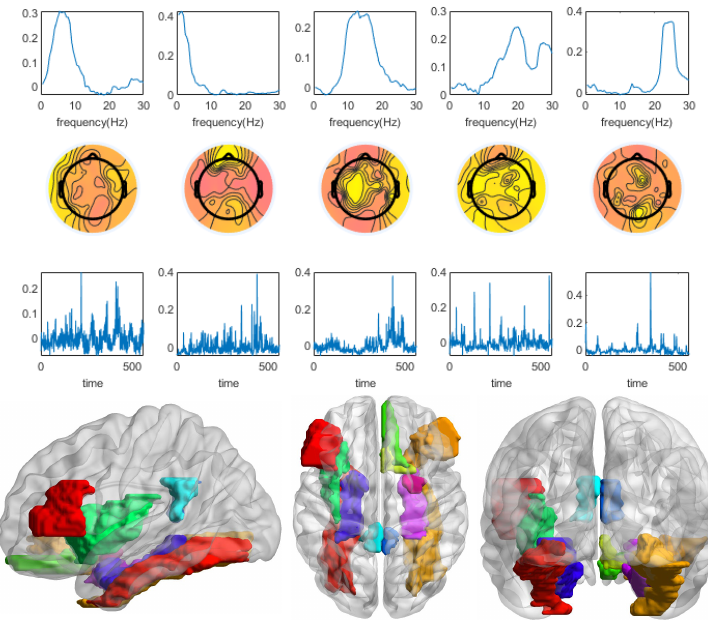
Figure 11. The CMTF results for subject 1 demonstrate the temporal signature 𝑠 (cid:3045) , spectral signature 𝑓 (cid:3045) , and spatial (channel) signature 𝑐 (cid:3045) of 5 sources in the EEG domain and ROI activation associated with the losing stimulus. The occurrence of activated ROIs known to be associated with the losing stimulus was counted for all subjects, as shown in Table 4. Activation was present in the inferior